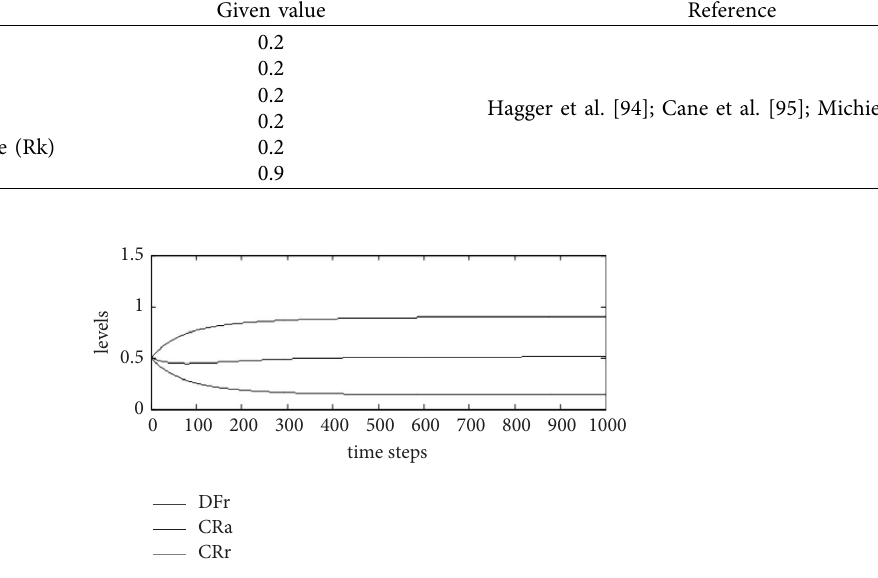
Figure 6: Te uninspiring case simulation.